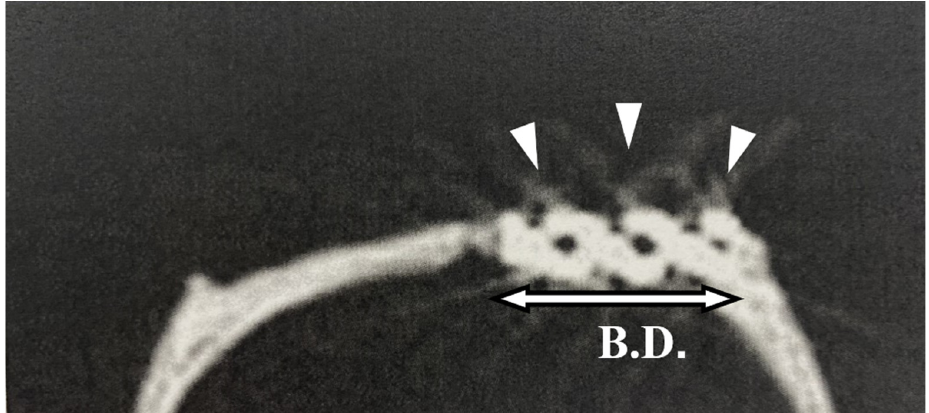
Figure 6. Micro-computed tomography image of a placed implant. The porous additive-manufac- turing titanium artificial bone (pAMTAB) is observed in the calvarial bone defect; there is no devi- ation. pAMTAB is denoted by arrow